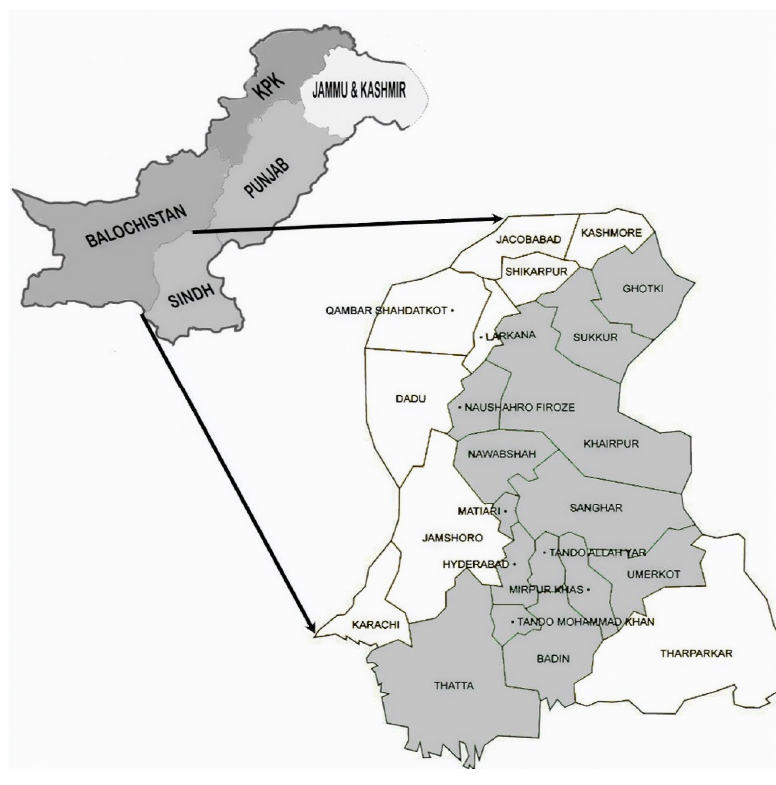
Figure 1. Study areas of Sindh, Pakistan.